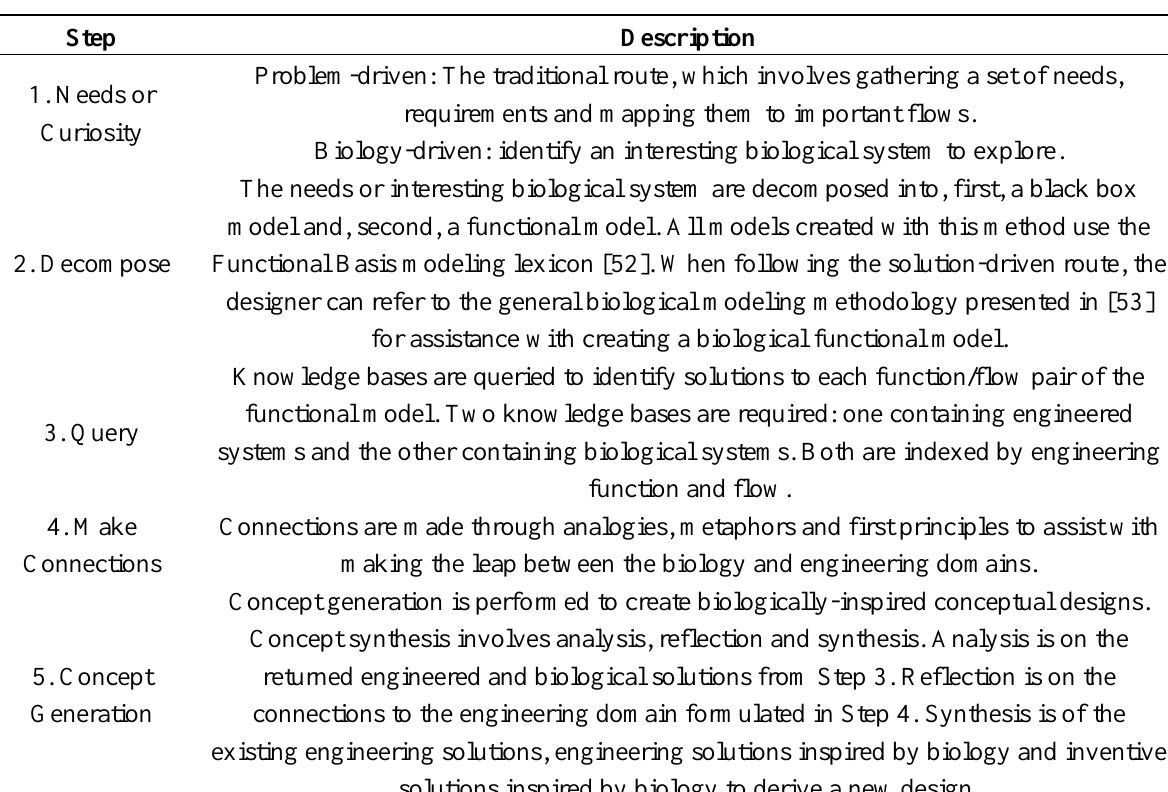
Table 1. Steps of the systematic design methodology for biologically-inspired design.